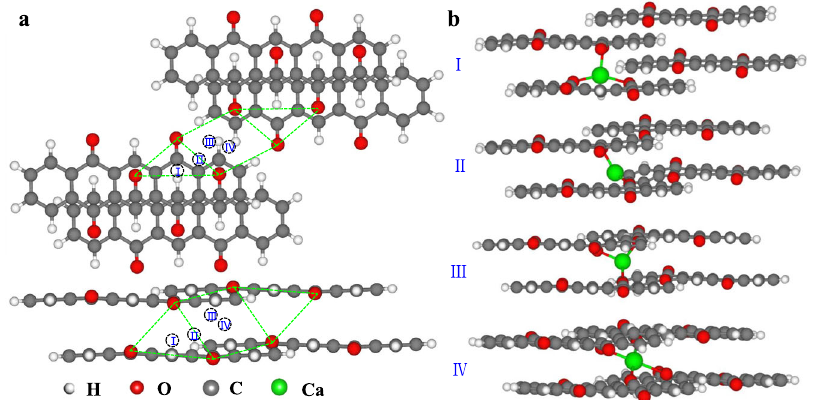
Fig. 7 Spatial distribution of the Ca ions con fi ned within the PT crystal channels. a The top view. The dotted circle represents the relevant equilibrium position for Ca, the green dotted line shows the distance between the adjacent O atoms. b The front view.